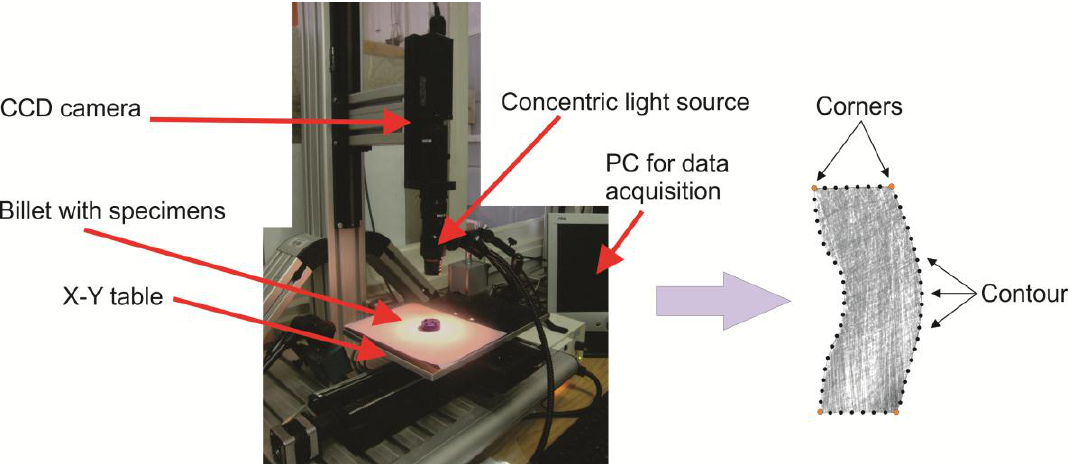
Figure 1. Acquisition of the specimen contour by a CCD camera.